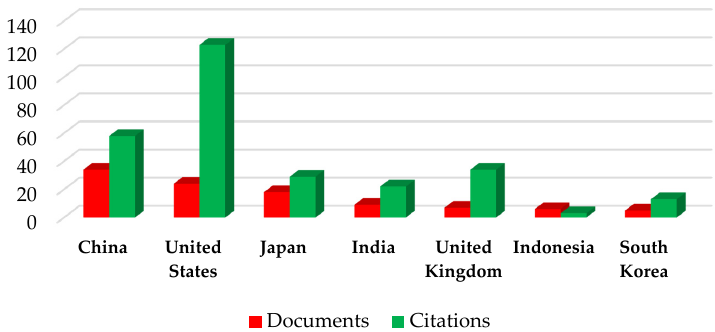
Figure 9. Country-wise contributions to and citations of the 139 reviewed articles from 2010 to 2020.